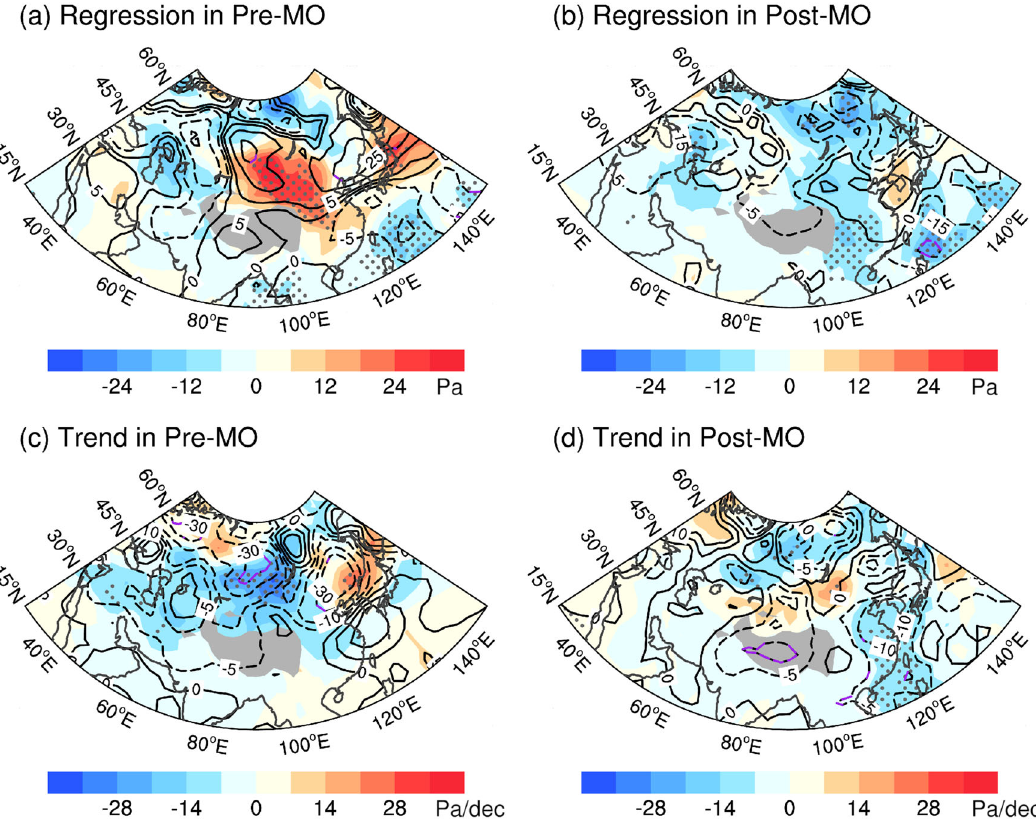
Fig. 4 Relationship between SC precipitation and mid-latitude synoptic disturbances. a , b Regressed root-mean-square (RMS) of 2 – 8-day fi ltered SLP (shading, Pa) and 500-hPa geopotential height (contours, m 2 /s 2 ) against precipitation index over SC (see Fig. 1c) and c , d trends in RMS of 2 – 8-day fi ltered SLP (shading, Pa/decade) and 500-hPa geopotential height (contours, m 2 /s 2 /decade)) in the (left) pre-MO and (right) post-MO periods. Stippled areas and purple contours are signi fi cant at the 0.05